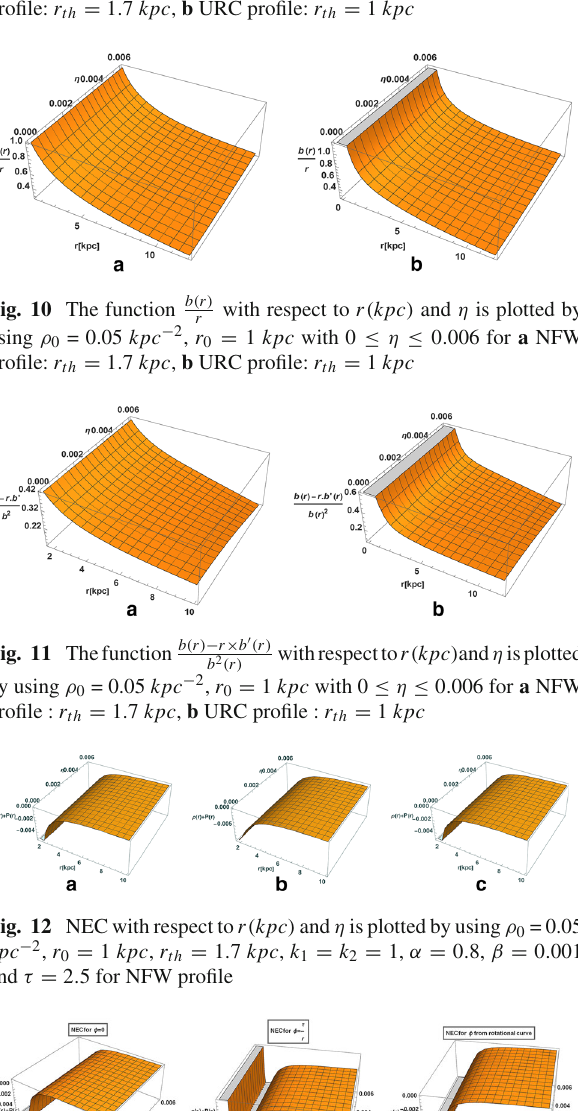
Fig. 9 The shape function b(r) with respect to r ( kpc ) and η is plotted by using ρ 0 = 0.05 kpc − 2 , r 0 = 1 kpc with 0 ≤ η ≤ 0 . 006 for a NFW profile: r th = 1 . 7 kpc , b URC profile: r th = 1 kpc